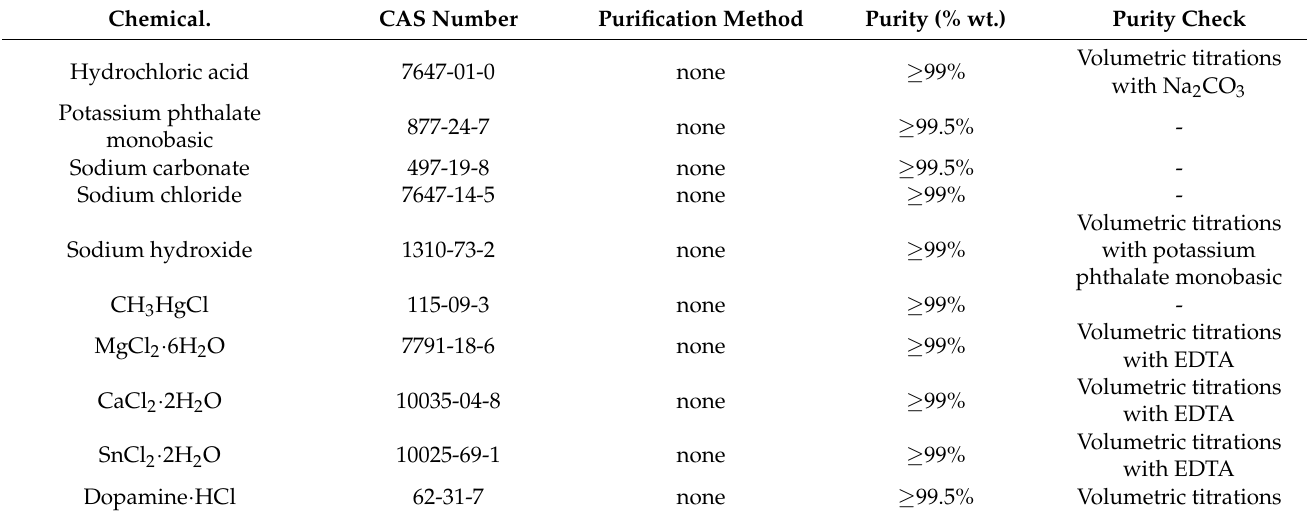
Table 1. Chemicals used in this work, purchased from Sigma-Aldrich, Italy.